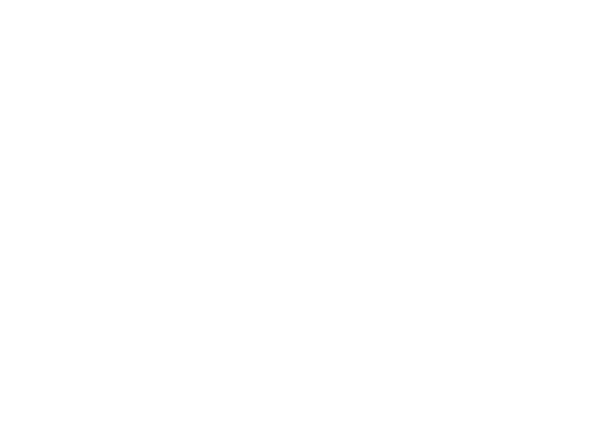
Fig. 3: Perforation on the anterior wall of